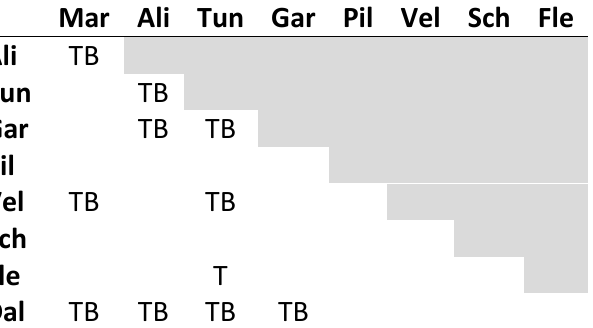
Tabela 7. Resumo das diferenças encontradas na aplicação dos métodos de Tukey e de Bonferroni. As letras T e B indicam, respectivamente, onde foram observadas diferenças significativas entre os grupos utilizando-se o método de Tukey e de Bonferroni. Table 7. Summary of differences found in the application of the Tukey and Bonferroni methods. The letters T and B indicate, respectively, where significant differences were found between groups using the Tukey and Bonferroni